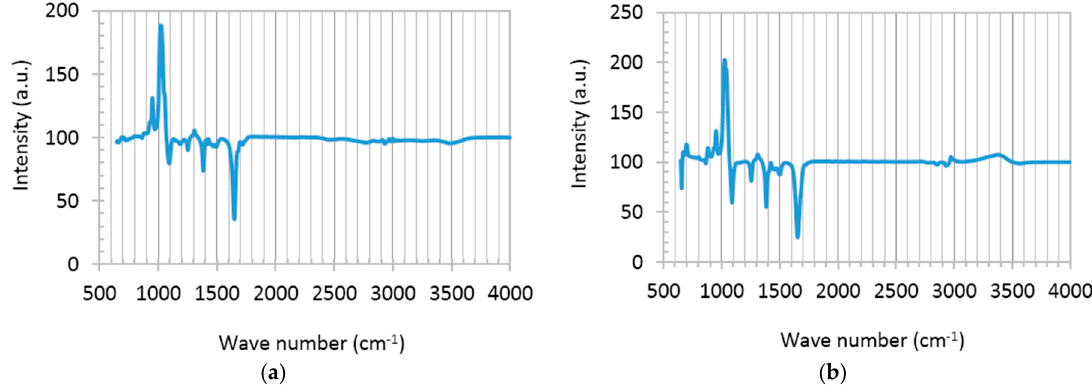
Figure 2. Liquid phase FTIR spectra of precursor solutions. ( a ) Graphene disperse (GD); and ( b ) hybrid TS:GD solution with volume ratio of 1:4.